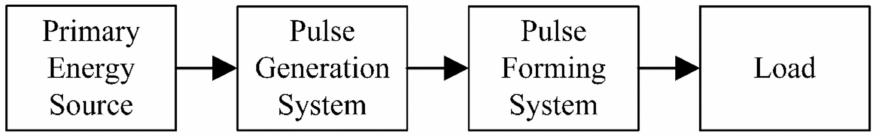
Figure 1. Block diagram of the high-power pulses multi-stage and cascade generation and form- ing